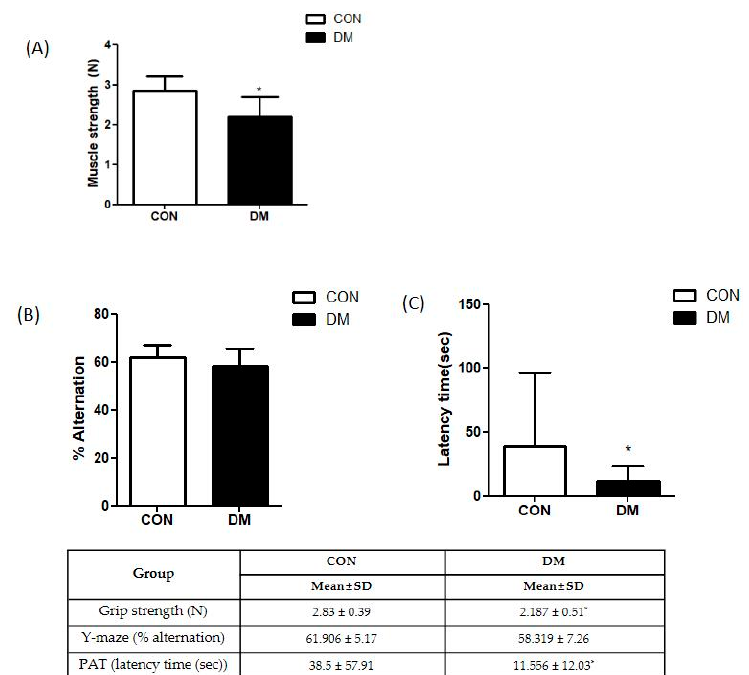
Figure 3 . Behavior test in T2DM mice ( A ) grip strength test and ( B ) Y-maze test ( C ) passive avoid- ance test All values are reported as mean and SD. The asterisk represents statistical significance of differences from * p < 0.05. n = nine mice in each group. CON, normal control mice; DM, diabetes mellitus